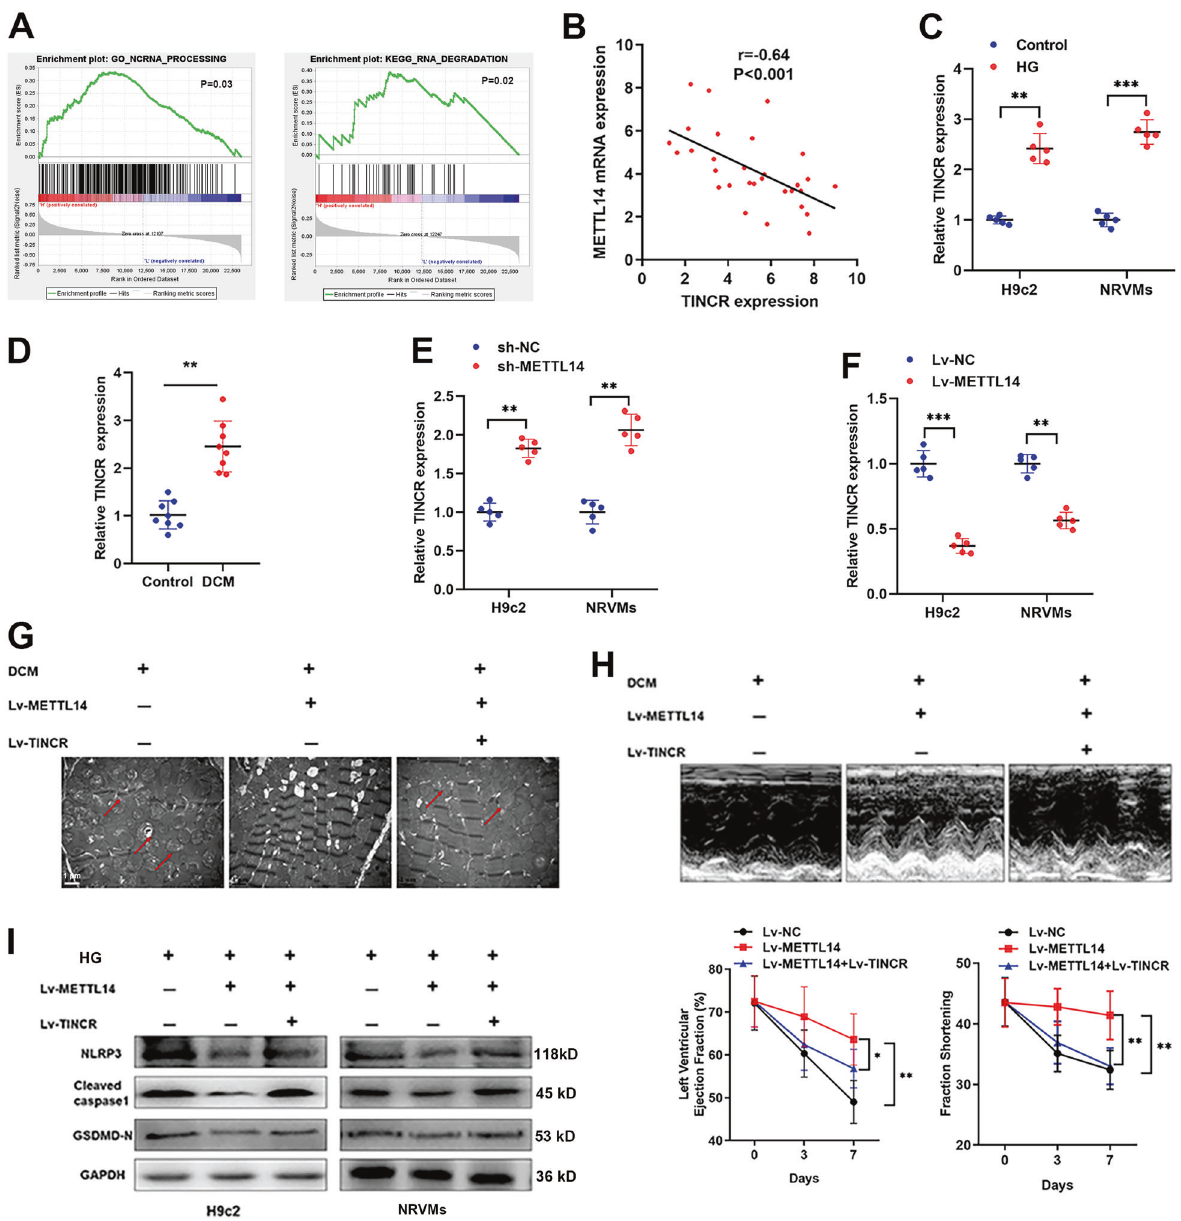
treatment of cardiomyocytes signi fi cantly increased TINCR expression, ** P < 0.01, *** P < 0.001. D . TINCR was signi fi cantly upregulated in DCM rats in contrast to controlled rats, ** P < 0.01. E , F qRT-PCR showed that silence of METTL14 ( E ) upregulated, while overexpression of METTL14 ( F ) suppressed TINCR expression in cardiomyocytes, ** P < 0.01. G , H Cardiac function analysis ( G ), electron microscopy imaging ( H ) showed that injection of METTL14 dramatically reversed the myocardial damage caused by DCM, however, co-expression of TINCR abrogated the METTL14-mediated in fl uence, * P < 0.05, ** P < 0.01. I The expressions of pyroptosis-related proteins was detected in H9c2 and NRVMs cells upon indicated